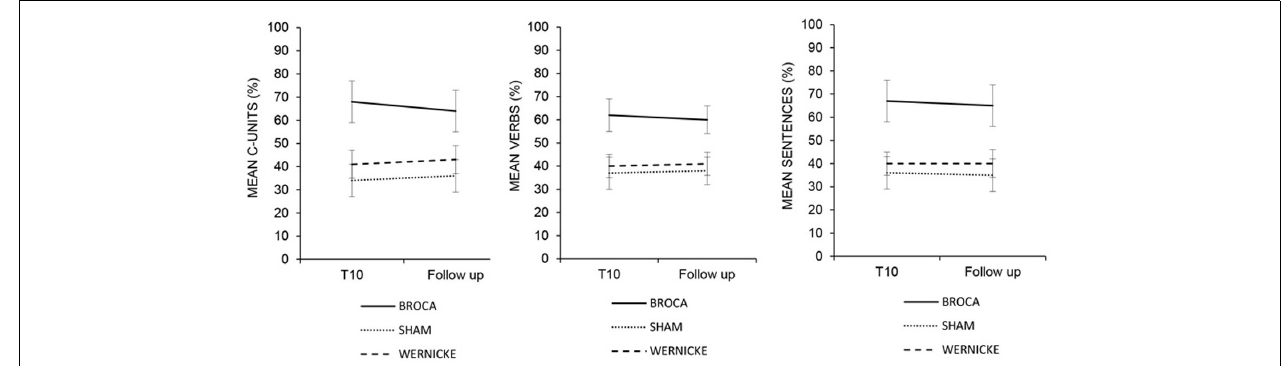
FIGURE 7 | Mean percentage of correct C-Units, Verbs and Sentences at the end of treatment (T10) and at the follow-up for the left anodic Wernicke’s, Broca’s and sham condition. Error bars represent standard error of the